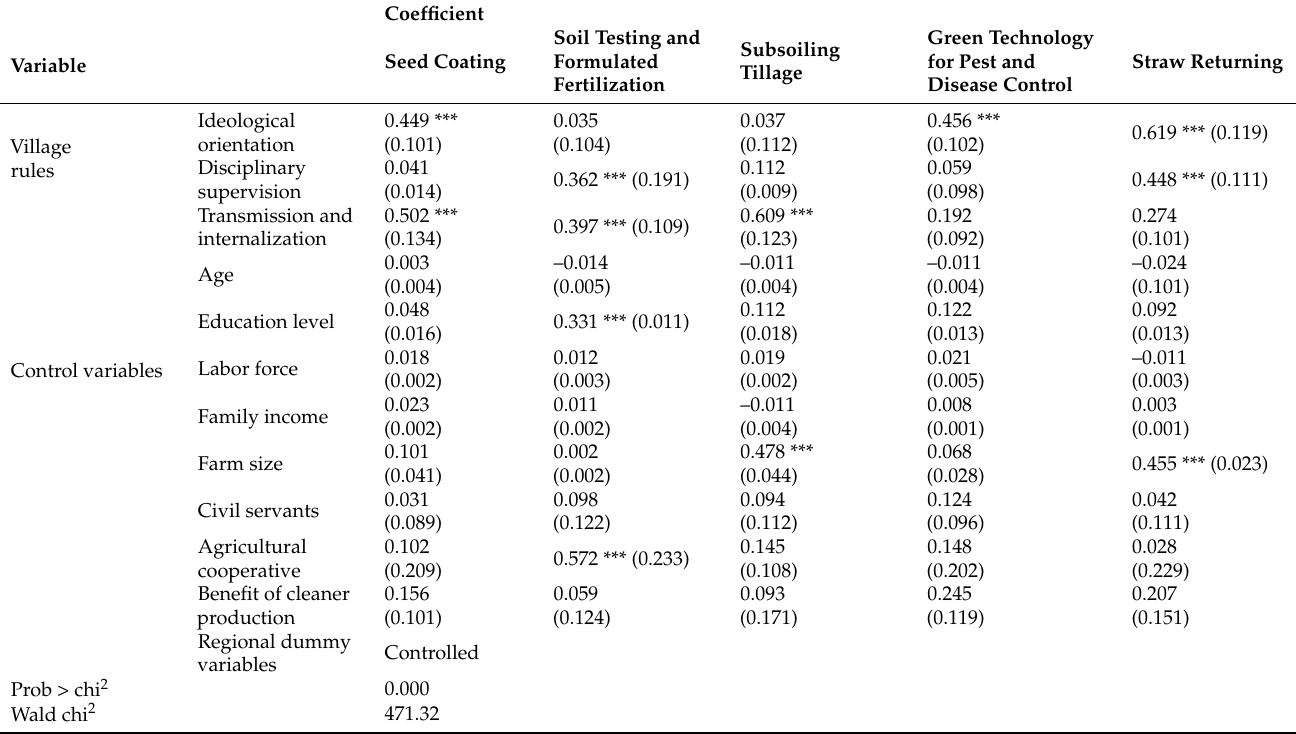
Table A1. Regression results of multivariate probit model (model 1).